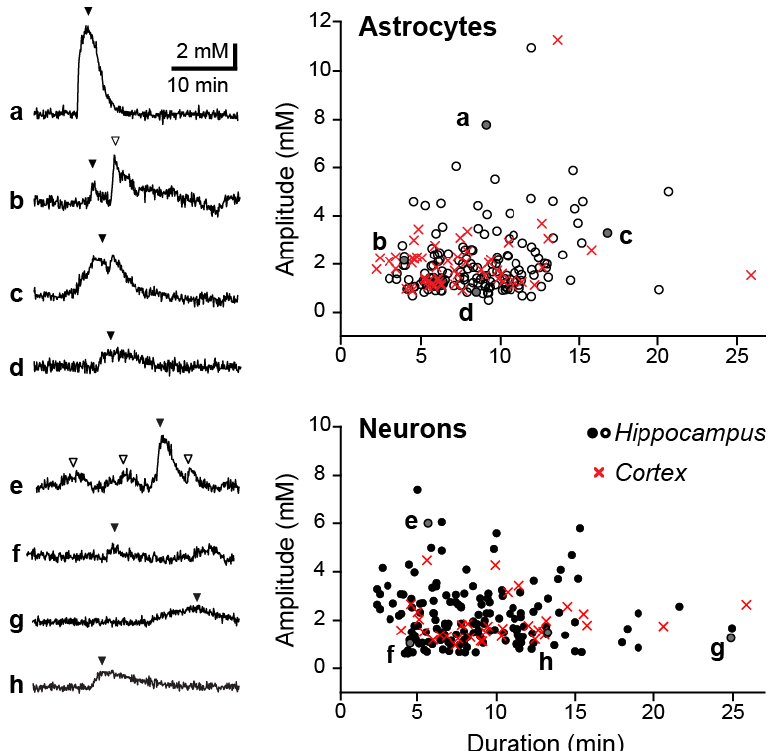
Figure 2. Properties of spontaneous Na + fluctuations. Left: Examples of individual Na + fluctuations in astrocytes ( a – d ) and neurons ( e – h ). Right: Scatter plot of all measured fluctuations in astrocytes (top) and neurons (bottom) with examples indicated by letters and shown by filled arrowheads on the left (hollow arrowheads are aditional fluctuations also analyzed).